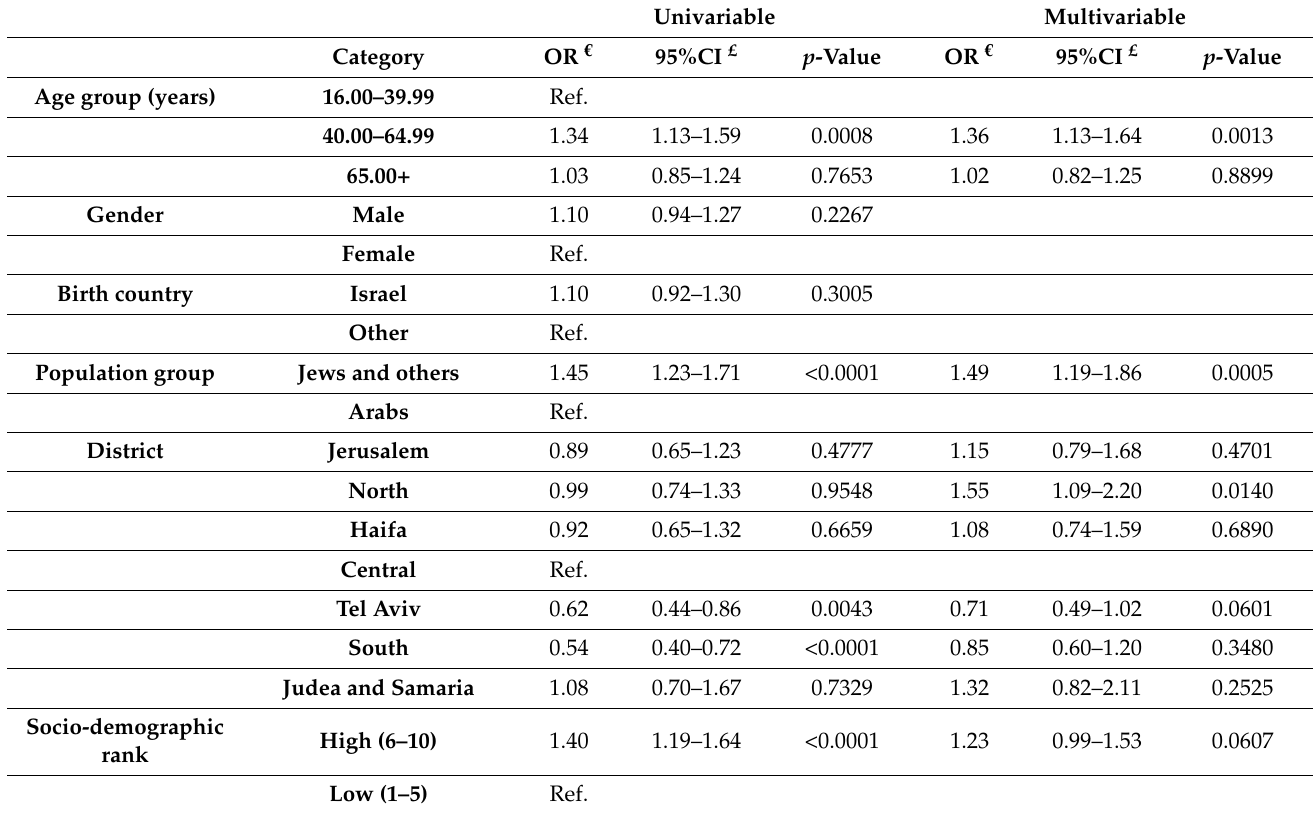
Table 4. Univariable and multivariable analyses for the association between SARS-CoV-2 seropositiv- ity and demographic characteristics in Israel, period 2 (January–July 2021). Univariable